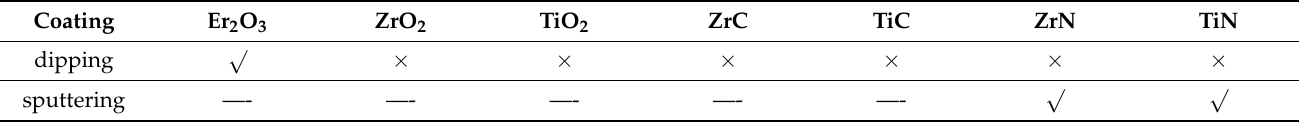
Table 1. The results of SiC/W joints with different diffusion barrier coatings joined at 1700 ◦ C for 1